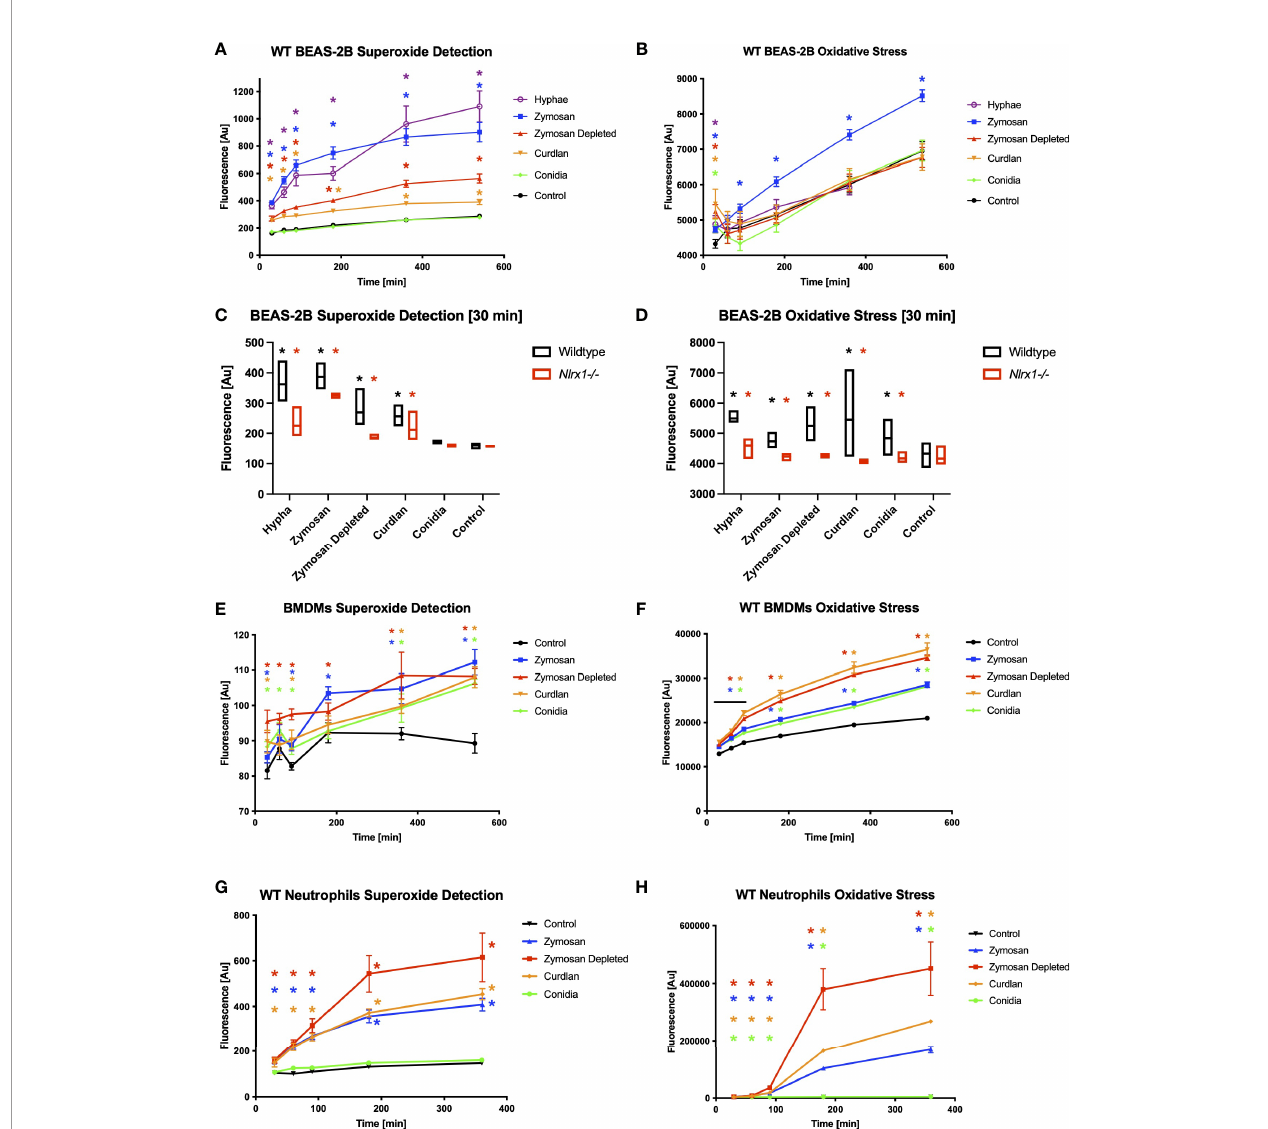
FIGURE 2 | Reactive oxygen species production and superoxide production in response to A. fumigatus conidia hyphae, and a subset of fungal PAMPs is dependent on Nlrx1. BEAS-2B airway epithelial cells were pre-stained for 30 min with cell-permeable, stable fl uorescent dyes speci fi c for (A, C, E, G) superoxide production or (B, D, F, G) general reactive oxygen species production prior to challenge. (A, B) Wild-type BEAS-2B cells, (E, F) bone marrow-derived macrophages, and (G, H) neutrophils were challenged for 9 h with killed A. fumigatus conidia, hyphae, and fungal PAMPs, and fl uorescence was measured 30, 60, 90, 180, 360, and 540 min post challenge. Colored asterisk (corresponding to treatment group) denotes p < 0.05 via Kruskal – Wallis test followed by a Dunn ’ s test for multiple comparisons against the control. (C, D) Fluorescence emission from wild-type and Nlrx1-de fi cient BEAS-2B cells 30 min post challenge. Black asterisk denotes p < 0.05 via Kruskal – Wallis test followed by a Dunn ’ s test for multiple comparisons against the control. Red asterisk denotes p < 0.05 between genotypes for a given treatment group. Supplementary Figures S1 – S3 show time course data for Nlrx1-de fi cient background compared to wild